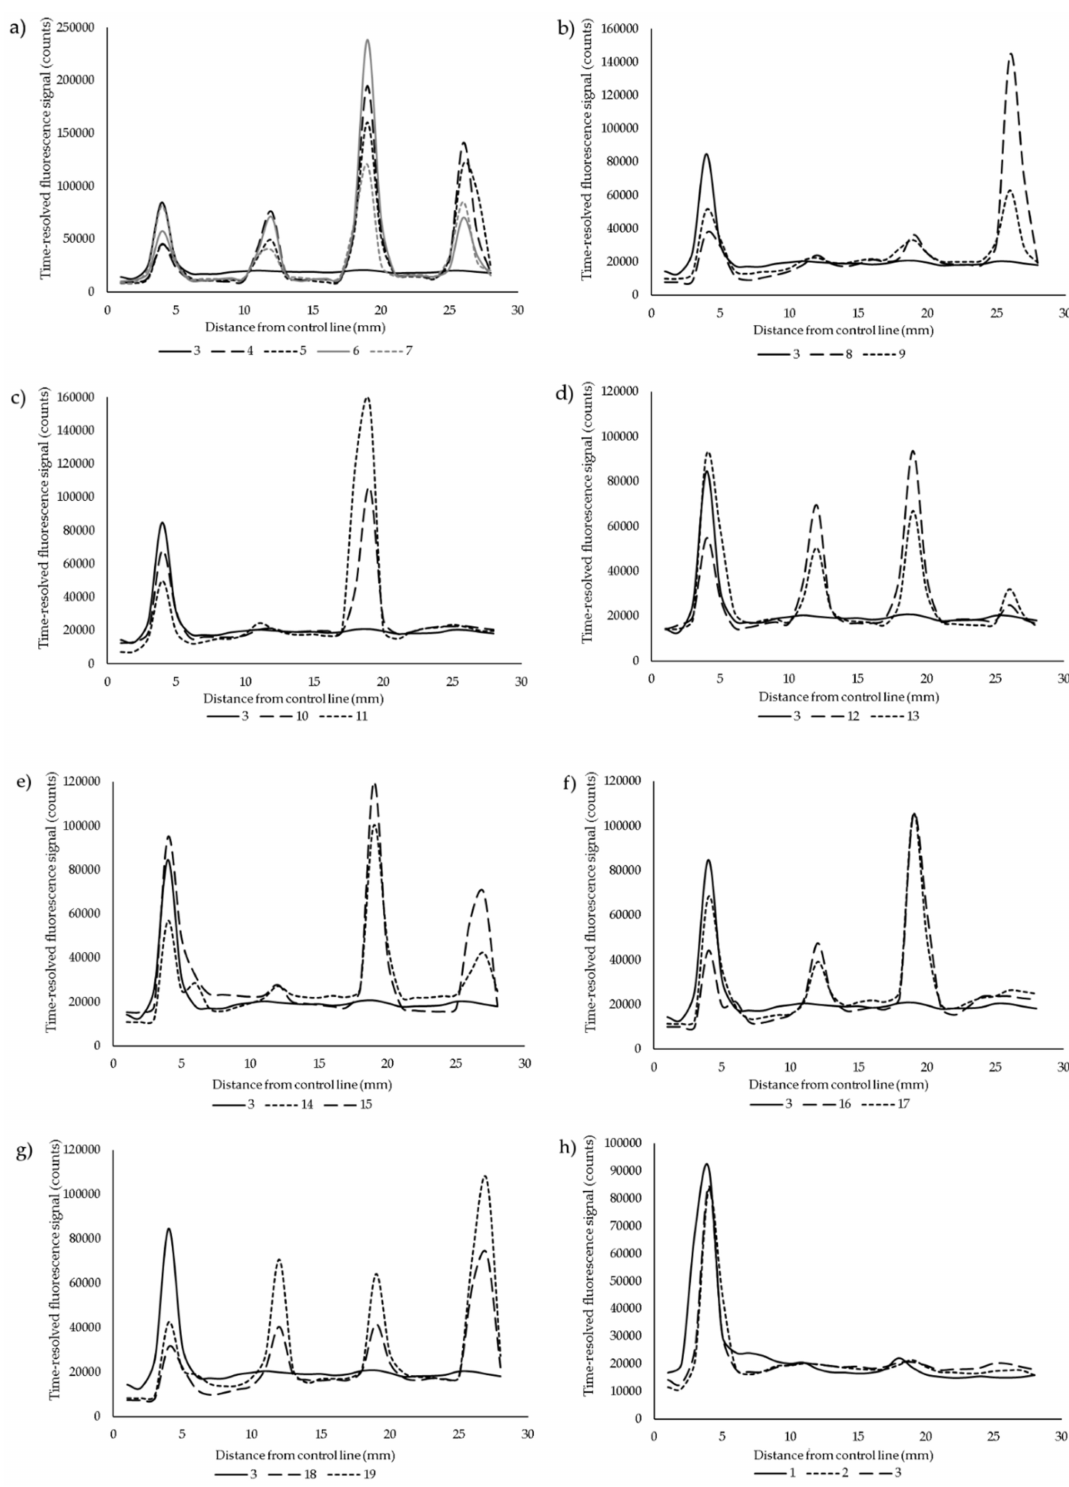
Figure 2. The multiplex readouts from lateral flow test strips were measured as average time-resolved fluorescence signal by line scanning the nitrocellulose membrane starting from the control line (4 mm), followed by FHA (12 mm), PT (19 mm) and PRN (27 mm) test lines. Di ff erent combinations of anti-PRN, -PT and -FHA-specific IgG antibodies were tested: ( a ) All positive (samples 4, 5, 6, 7), ( b ) only PRN IgG positive (8, 9), ( c ) only PT positive (10, 11), ( d ) only FHA positive (12, 13), ( e ) both PRN and PT positive (14, 15), ( f ) both PT and FHA positive (16, 17), ( g ) both PRN and FHA positive, (18, 19), and ( h ) all negative samples (1, 2, 3). Please refer to Table 1 for antibody